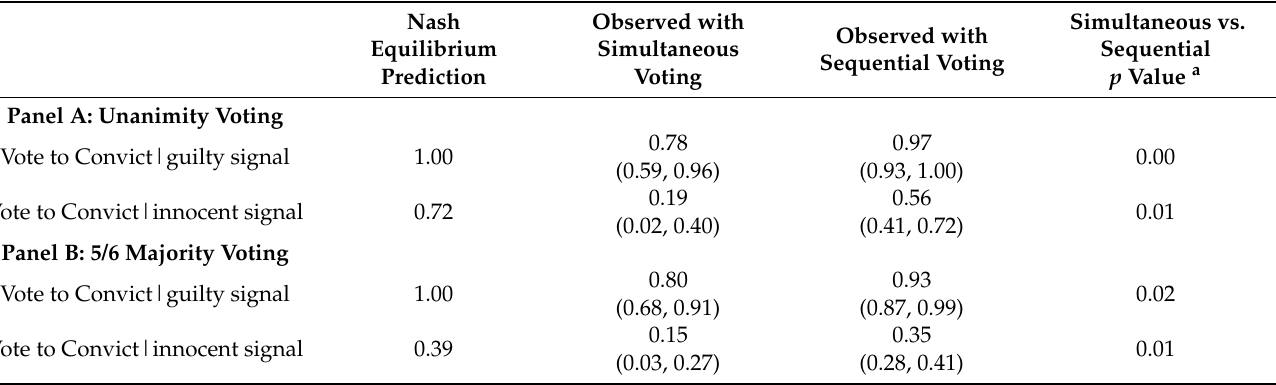
Simultaneous vs. Sequential p Value